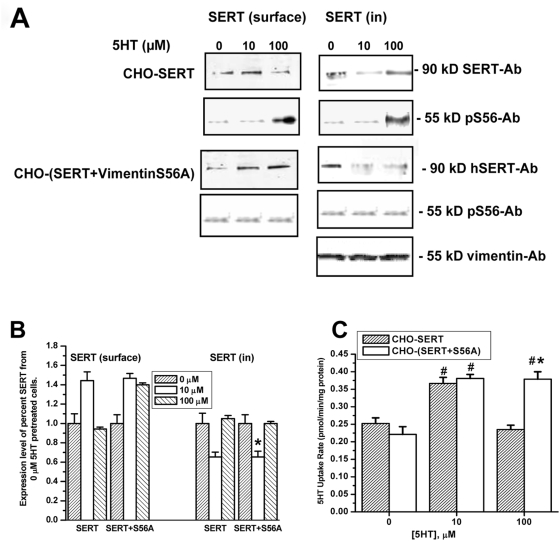
Effect of SERT-vimentin interaction on the surface expression of SERT.
(A) CHO-SERT cells were pretreated with 0, 10, or 100 μM 5HT and biotinylated with NHS-SS-biotin (15, 16, 19). Biotinylated plasma membrane proteins were retrieved on streptavidin beads and analyzed for SERT or phosphovimentin- (pS56-) Ab by W/B. All lanes contain protein recovered from the same number of cells equivalent to one well from a confluent 24-well culture plate. (B) Intracellular SERT, vimentin, and phosphovimentin were also determined by W/B analysis of non-bound material. Mock-transfected CHO cells served as a control. Vimentin served as a loading control. The results of W/B analysis are the summaries of combined data from three densitometric scans. * represent differences from 0 μM 5HT-matched samples. All lanes contain protein recovered from the same number of cells equivalent to 30% of one well from a confluent 24-well culture plate. (C) CHO cells expressing SERT and phosphovimentin mutant S56A were first pretreated with (0–100 μM) 5HT, and then their 5HT uptake rates were measured in intact cells as described under “Materials and Methods.” Background accumulation of (3H)-serotonin was measured in the same experiment using mock-transfected cells and subtracted from each experimental value. Maximum background accumulation was 0.01 pmol/mg protein/min. Rate of uptake is expressed as the means and SD values of triplicate determinations from three independent experiments. ANOVA indicated that the interaction between 5HT level and cell line was highly significant (p<0.001) for both figures (B and C). Post-hoc comparisons were adjusted using a Bonferroni correction. Significant comparisons with the uptake rates of mock transfected CHO cells within 5HT level are indicated with *, and with 0 μM 5HT within cell line are indicated with # (all p≤0.001).